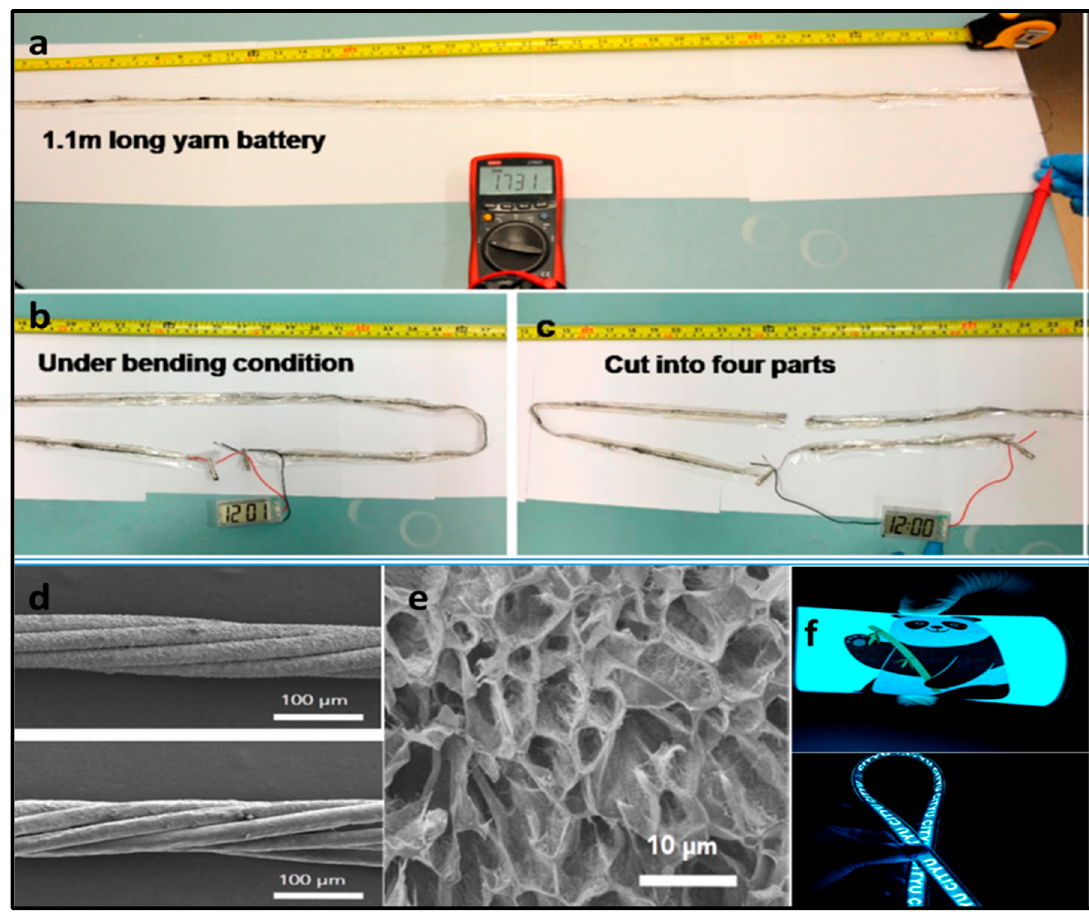
Figure 13. Tailoring test and demonstration of solid-state yarn ZIBs. ( a ) Optical image of the as-prepared 1.1 m long yarn ZIB. ( b ) Long yarn ZIB under bending condition. ( c ) Long yarn battery was cut into four parts, and each part can power the digital watch. ( d ) SEM images of the CNT@Zn yarn ( top ) and SEM images of the CNT@ MnO 2 yarn ( bottom ). ( e ) SEM image of the freestanding PAM. ( f ) Eight segmented yarn batteries were connected in series to power a 100 cm 2 electroluminescent panel (size 10.0 × 10.0 cm) under di ff erent bending conditions and a 1 m long electroluminescent panel (size 1.0 × 100 cm). Reproduced with permission from [162]. Copyright 2018 the American Chemical